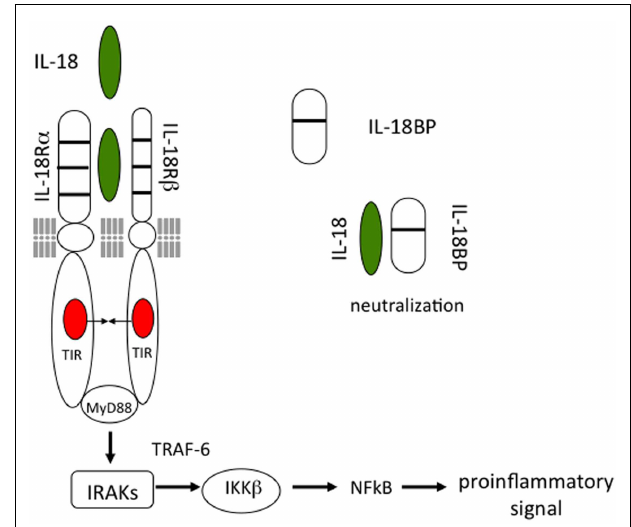
FIGURE 1 | Interleukin-18 signal transduction . IL-18 forms a signaling complex by binding to the IL-18 alpha chain (IL-18R α ).The co-receptor, termed IL-18 receptor beta chain (IL-18R β ), is recruited to form a high affinity complex. Following the formation of the heterodimer, theToll-IL-1 receptor (TIR) domains approximate triggering the binding of MyD88, phosphorylations of the four IRAKs,TRAF-6, and activation of NF κ B.The IL-18BP is present in the extracellular compartment where it binds mature IL-18 and prevents binding to the IL-18 receptor.